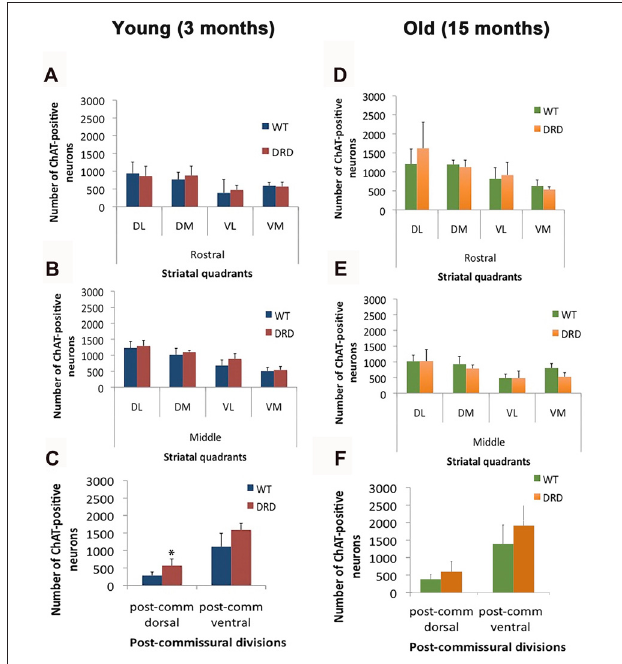
FIGURE 2 | (A–F) Number of ChAT-positive neurons (average values ± SEM) in various quadrants and divisions of the rostral, middle and post-commissural tiers of the DS of young (3 months old; A–C ) and old (15 months old; D–F ) WT and DRD mice ( ∗ p < 0.05).